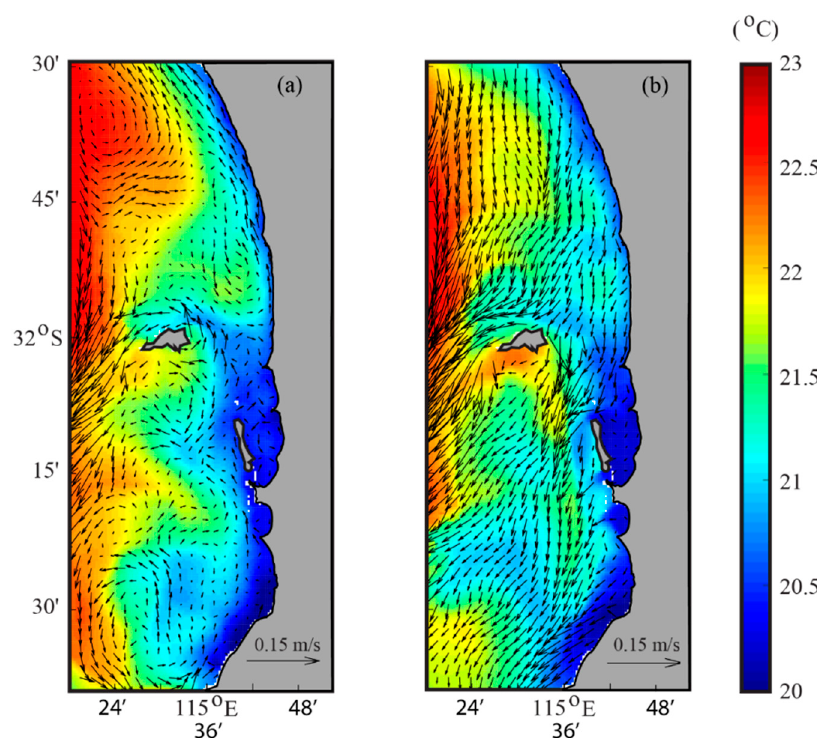
Figure 11. Predicted near-bottom mean velocity and near-bottom temperature during two low wind events: ( a ) May 7–9, 2016; and ( b ) May 10–12, 2016. The near-bottom velocities and temperature were averaged over 3 days.